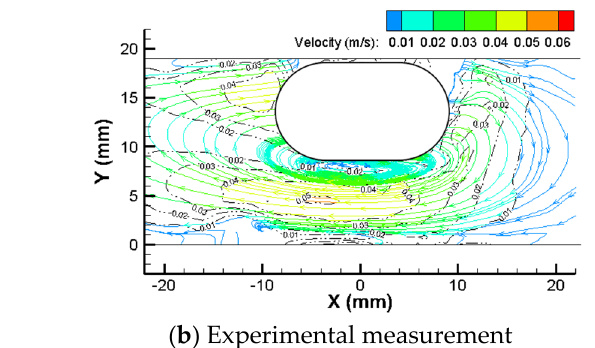
8 of 17 Figure 8. Parts of the capsule robot. 1—Front end cap; 2—Magnet; 3—Middle section; 4—Rear end cap. 4.2. Comparison between Numerical Calculation and Experimental Measurement